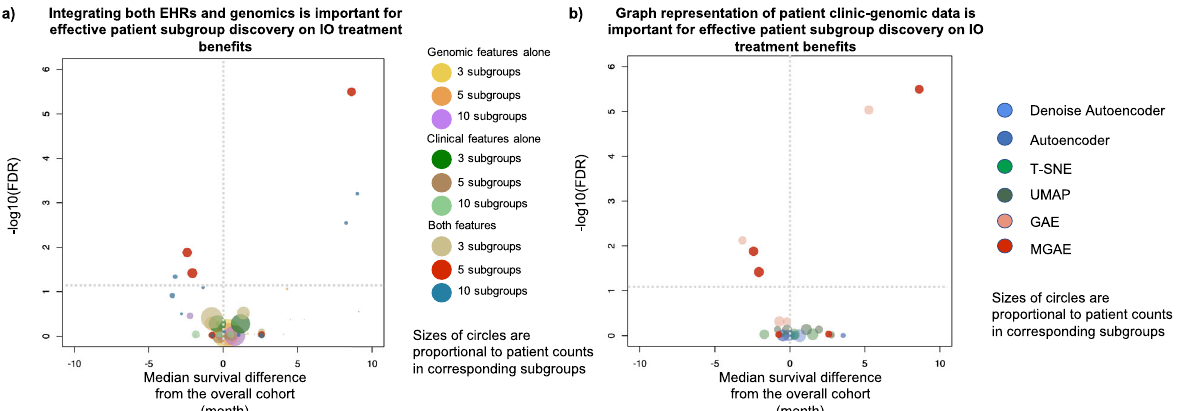
Fig. 3 Graph representation of patient data and integration of both EHR and genomics data are essential toward identifying patient subgroups with differential IO-treatment bene fi ts. In both volcano bubble plots, each bubble represents a patient subgroup, the x axis represents the difference of the estimated median survival times between a patient subgroup and the overall cohort as control. The vertical line marked zero median survival difference, with bubbles on the right of the vertical line showing the tendency of bene fi cial IO outcomes and bubbles on the left showing the tendency of IO non-bene fi cial outcomes. y axis is the − log10(FDR) of the corresponding log-rank test between a subgroup vs. the overall cohort with multiple-comparison adjustment by Benjamini – Hochberg procedure, representing the statistical signi fi cance of the observed survival difference. The horizontal dashed line marked the statistical signi fi cance cutoff of FDR of 0.05. a Integrating both EHRs and genomics is important for effective patient subgroup discovery on IO treatment bene fi ts and setting the number of clusters (subgroups) to fi ve outperforms cluster number of three or ten. We compared patient subgrouping using both types of features versus using EHR or genomics features alone. To make a robust comparison, we explored different number of resulting subgroups, including three, fi ve, and ten subgroups respectively. Integrating both types of features discovers patient subgroups with signi fi cant IO bene fi cial and non-bene fi cial outcomes, while individual features alone do not identify any subgroup with signi fi cant IO bene fi cial or non-bene fi cial outcomes. In the setting of incorporating both genomic and clinical features, we obtained optimized results when the targeted number of clusters was set to 5, which is able to identify more patients with signi fi cant IO bene fi cial and non-bene fi cial outcomes and with stronger statistical con fi dence. b Graph representation of patient clinico-genomic data is important for effective patient subgroup discovery on IO treatment bene fi ts. Subgrouping results compared with other methods demonstrates that graph representation of patient data (MGAE and